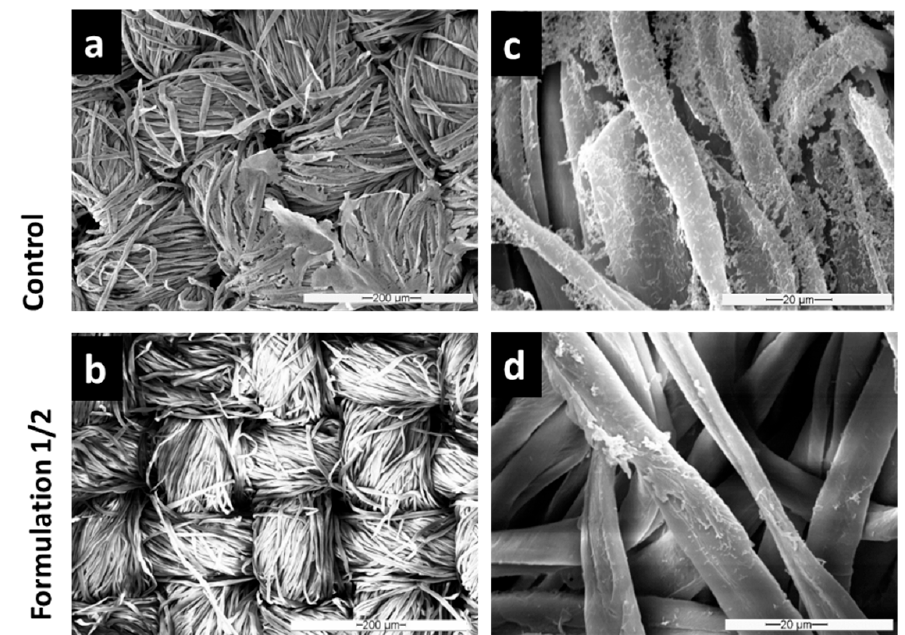
there were even less residual single bacteria or biomass found after exposure with F1/2, Figure 6. SEM images of P. aeruginosa grown for 48 h to form biofilms on cellulose substrates after 1 h Figure 6. SEM images of P. aeruginosa grown for 48 h to form biofilms on cellulose substrates after 1 as illustrated by the clean fibers in both Figures 6b,d and 7B. of washing with Formulation 1/2 ( b , d ) in comparison to untreated controls ( a , c ). h of washing with Formulation 1/2 ( b , d ) in comparison to untreated controls ( a , c ). Although P. aeruginosa biofilms seemed to exhibit an even higher fiber coverage and layer thickness in the control condition (Figures 6a,c and 7A) than P. fluorescens biofilms,